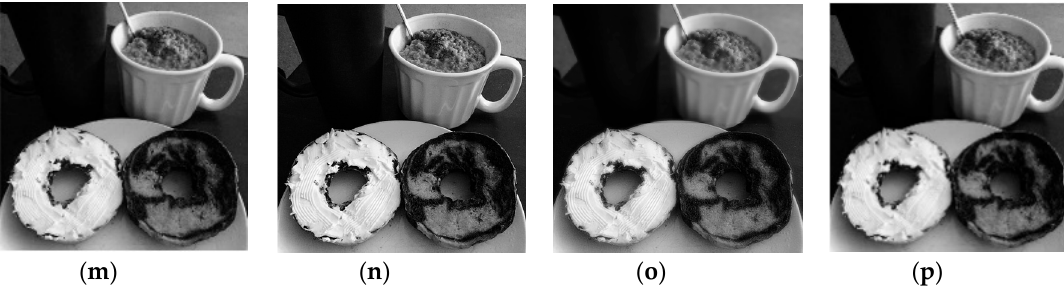
Figure 10. Fused images obtained by di ff erent methods in the image pair “bread”. ( a ) PCA; ( b ) SWPCA; ( c ) MWPCA; ( d ) DWT; ( e ) GP; ( f ) MSVD; ( g ) CSR; ( h ) FSD; ( i ) DCHWT; ( j ) MGFF; ( k ) MMGD; ( l ) SWT; ( m ) LPPCNN; ( n ) BRWIF; ( o ) FPED; ( p ) SVM-MWPCA. Table 1. Evaluation indexes of the fused images in source image pair “head”.